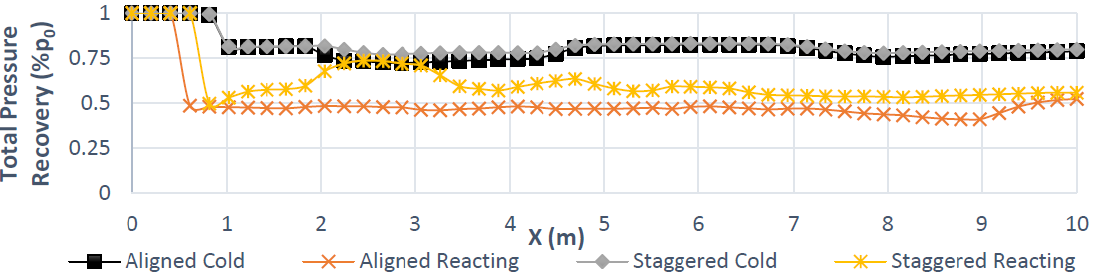
Figure 19. Total pressure loss comparison of aligned and staggered injector arrangement.